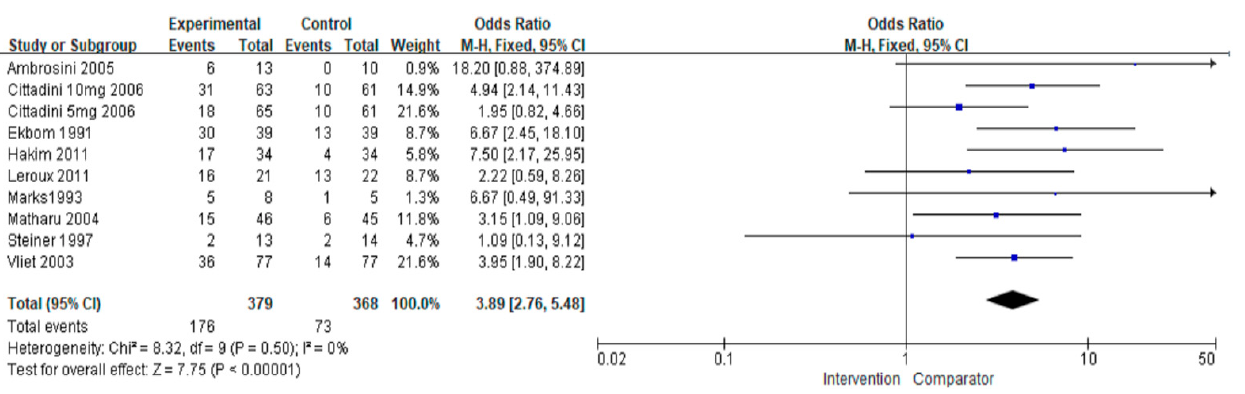
Figure 4. Overall network meta-analysis results of each outcome. ( a ) Frequency of attacks; ( b ) pain-free rate; ( c ) duration of attacks; ( d ) number of patients using rescue agents; ( e ) adverse events. * Statistical significance.